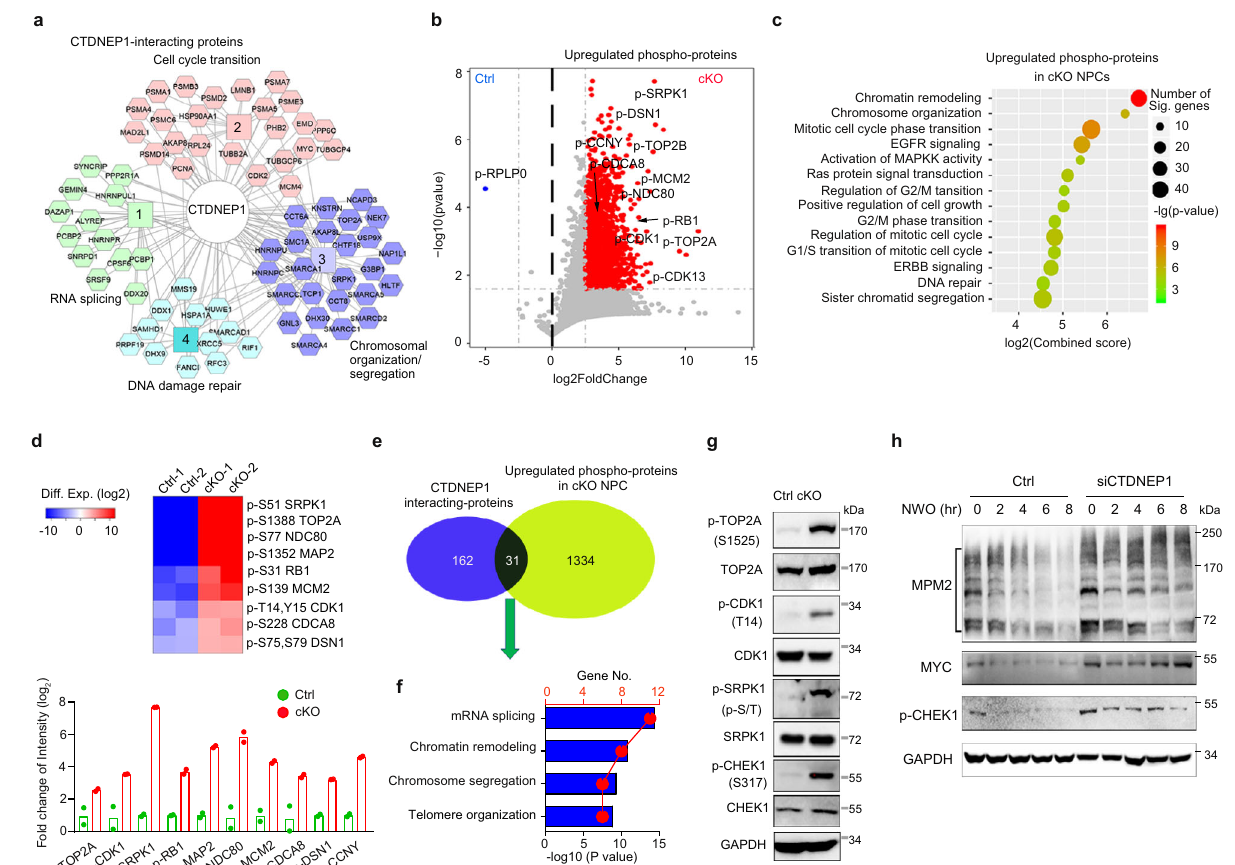
Fig.6|CTDNEP1post-translationallymodulatestheactivitiesofkeyregulators for chromosome decatenation and mitotic checkpoints. a CTDNEP1-interating proteins identi fi ed by mass spectrographic analysis in 293T cells which was expressing HA-tag CTDNEP1. b Mass spectroscopy analysis of phosphorylated proteinsin Ctdnep1 -cKONPCs(cKO)atDIC10comparedwithCtrlNPCs.Two-tailed unpaired Student ’ s t test. c Pathwayanalysis of the most differentially upregulated phospho-proteins in Ctdnep1 -cKO NPCs compared with wild-type NPCs. Fisher exact test. d Upper, representative phosphorylated proteins involved in cell-cycle progression that are enriched in Ctdnep1 -cKO NPCs compared to control NPCs. Lower panel; the phosphorylation intensity of mitosis and chromosome segrega- tion proteins in the NPCs detected by mass spectrometry. Data represent means,